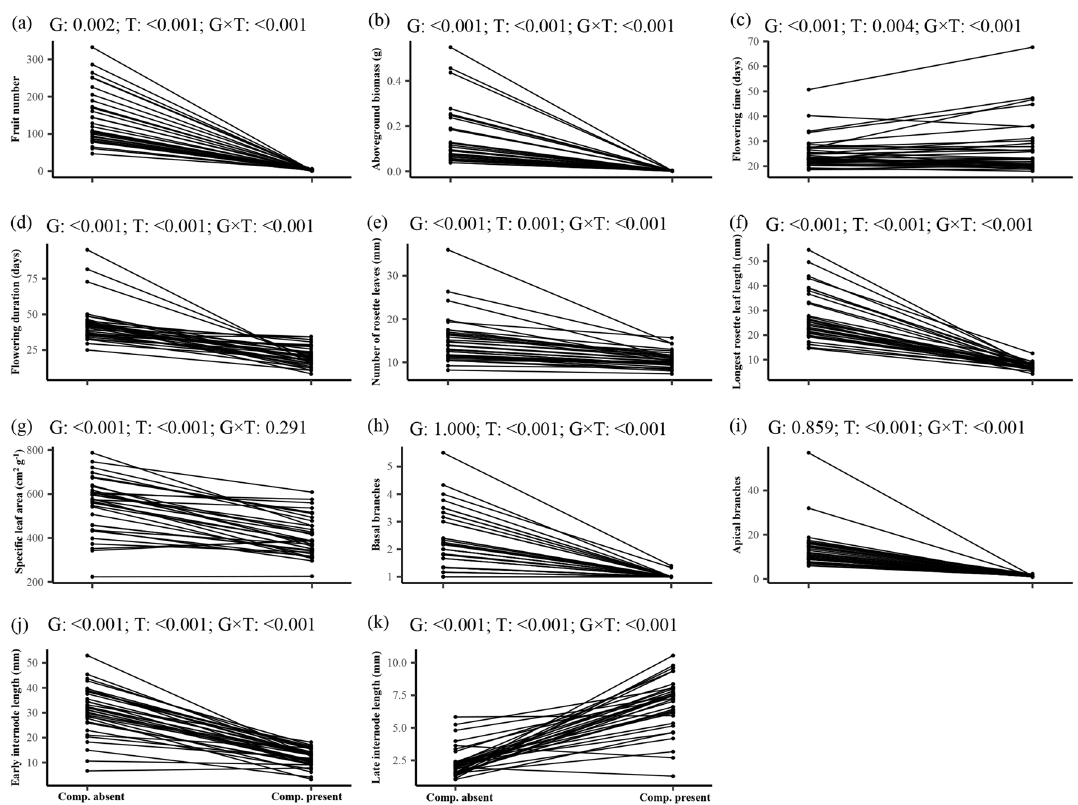
Figure 1. Reaction norms for performance and trait variation in response to competition treatments across thirty-five Arabidopsis genotypes. Each point represents a genotype mean value in either competition-absent or competition-present conditions. P values from linear mixed models testing the effect of genotype (G), treatment (T) and their interaction (G × T) are